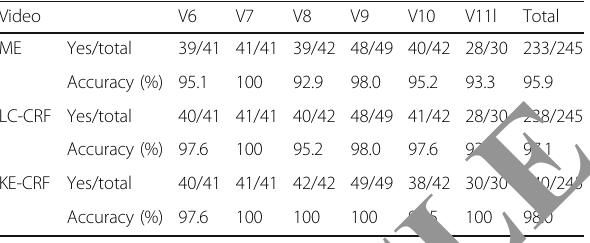
Table 3 Comparison of the accuracy of score recognition before and after conversion of different CRF models